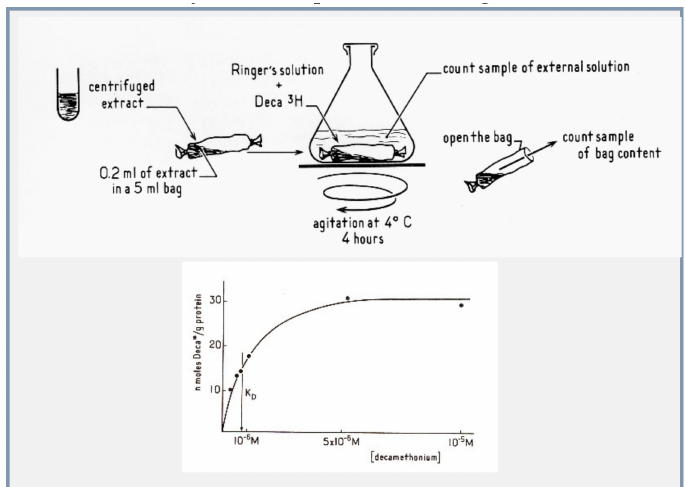
Figure 5. Application of the equilibrium dialysis method of Gilbert and Müller-Hill to isolate the nAChR top method (as described in [34]), bottom binding data (reproduced from